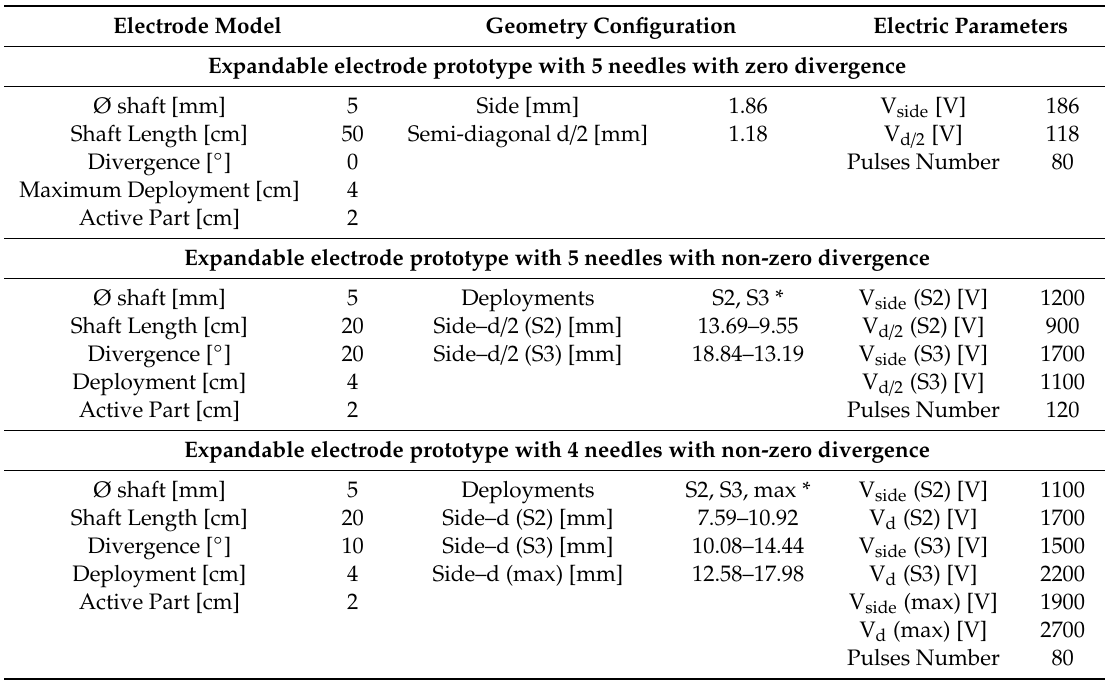
Table 1. Characteristics of tested electrodes with 5 and 4 needles, including technical proprieties (shaft diameter Ø, shaft length, divergence, maximum deployment and active part), geometry configuration and electric